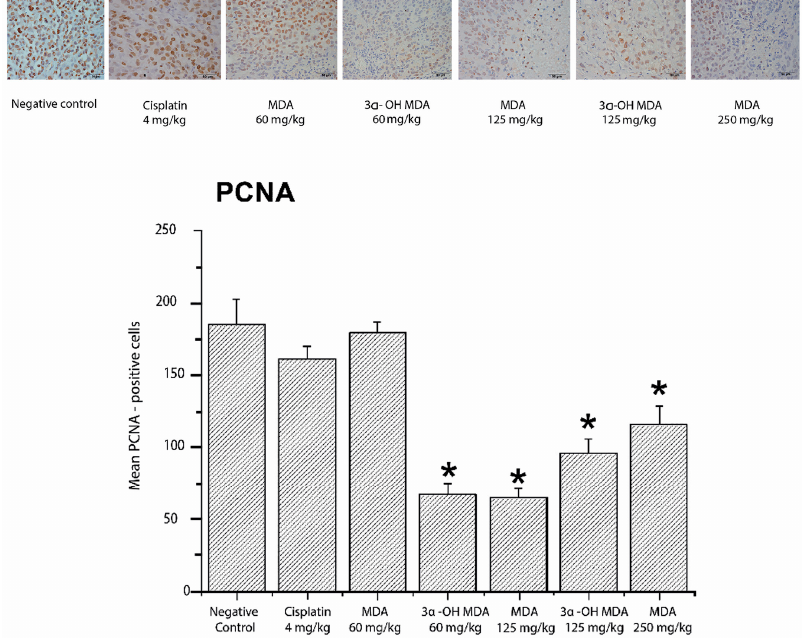
Figure 4. IHC analysis for the proliferating cell nuclear antigen (PCNA) in tumor tissues from mice treated with MDA or 3 α -OH MDA for 21 days. The images in Figures 3–6 were acquired at 40 × using an acquisition software of images (Nis Elements-F). The values across the histogram represent the result of quantitative analysis of PCNA-positive cells. The data are shown as the means ± SEM of three xenografts analyzed for each group. * p < 0.05, significant differences compared with the control.